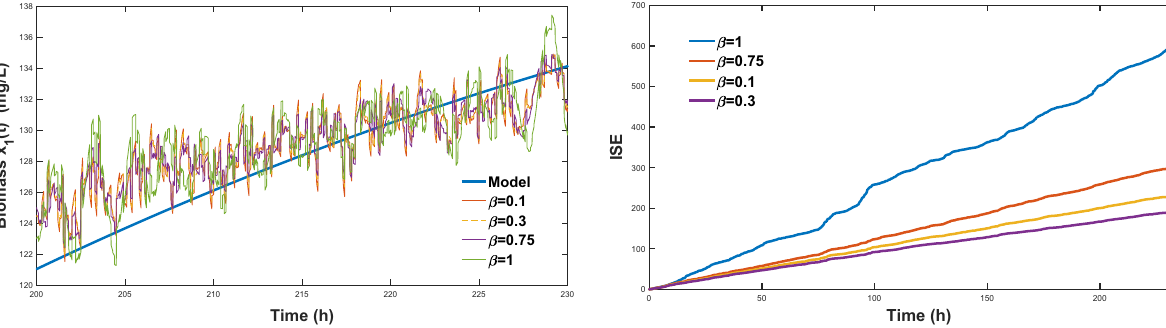
Figure 8: Comparison of the Nutrients dynamics in presence of the four di ff erent controllers with a change of the beta.